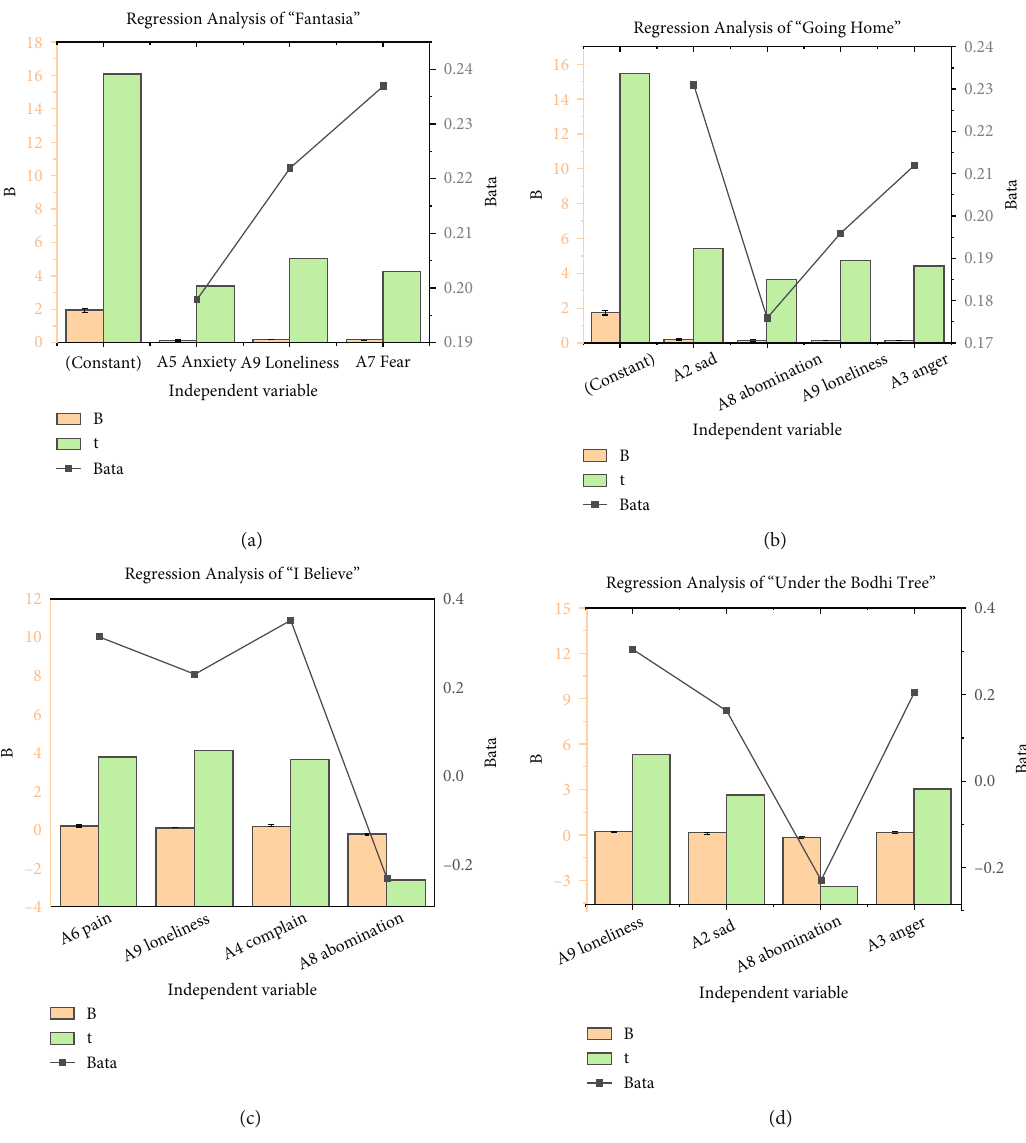
Figure 6: The survey results of the music alleviation on negative emotions (the vertical coordinate B represents the nonstandardized coe ffi cient, which shares the same as that in the following fi gures. (a) Fantasia ; (b) Going home ; (c) I believe ; (d) Under the Bodhi tree